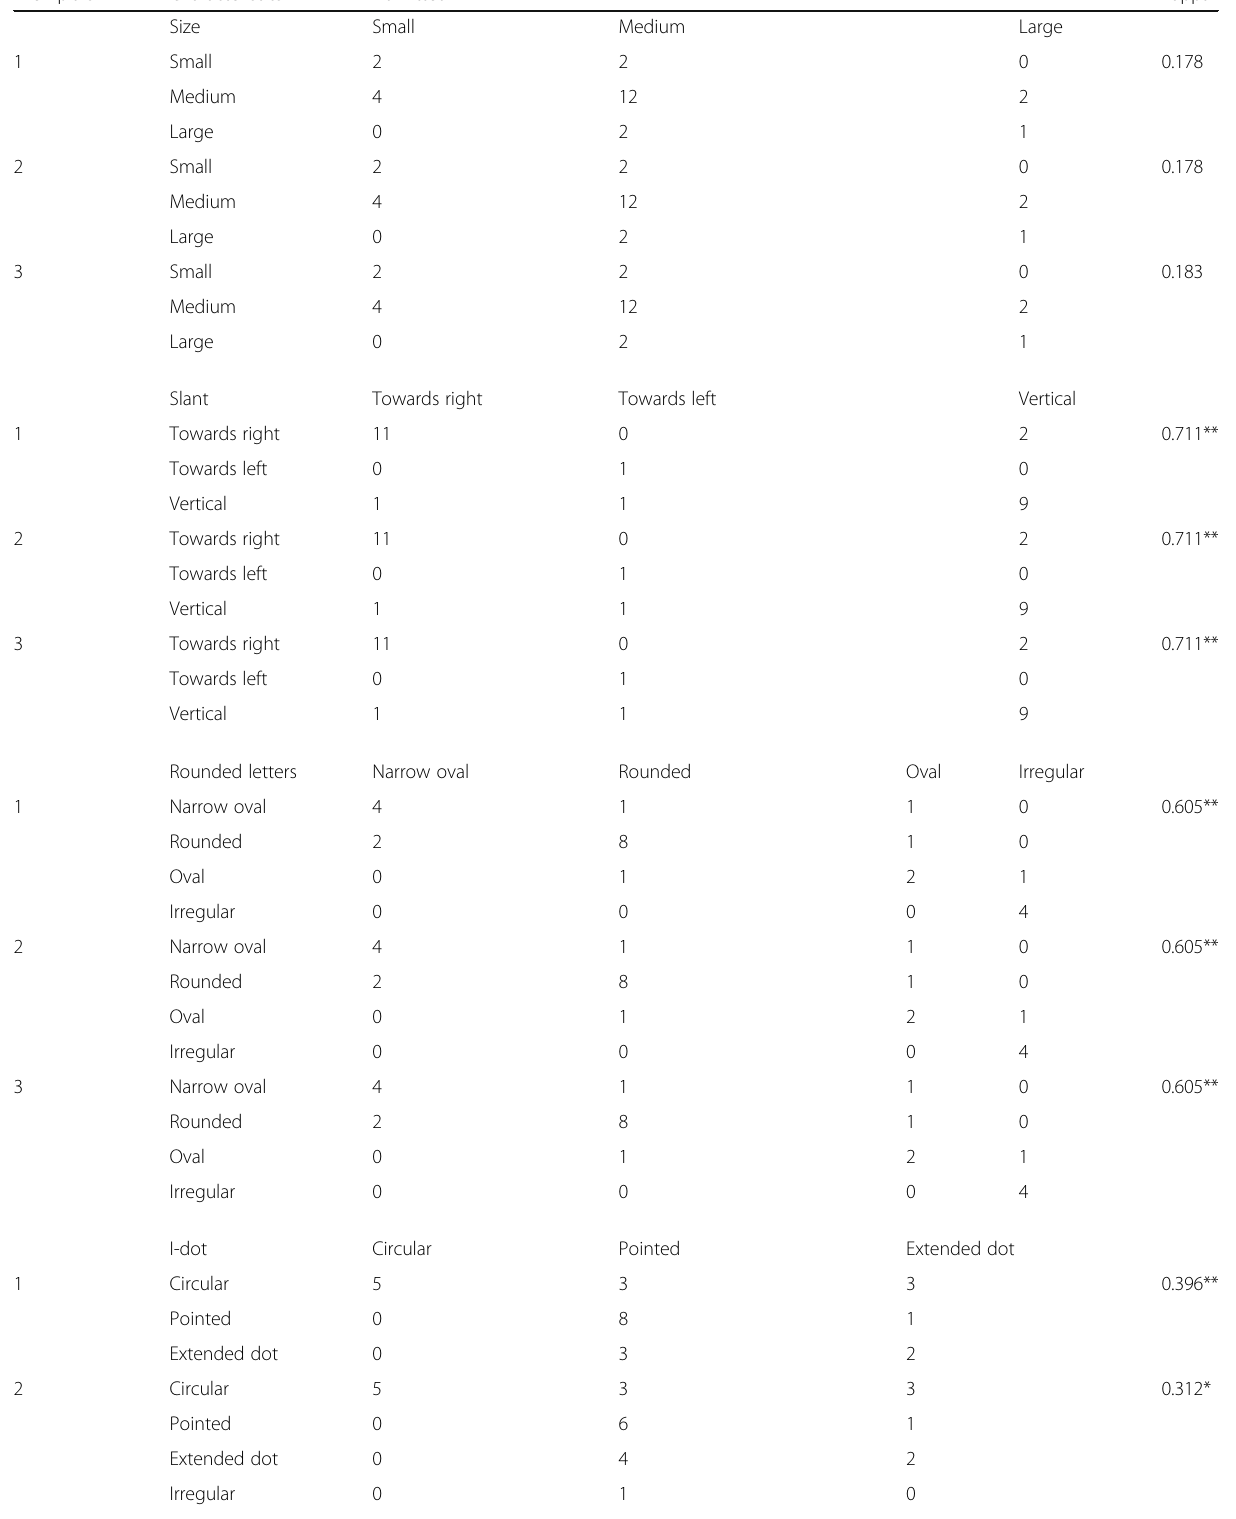
Table 3 Cohen ’ s kappa coefficient showing the agreement in characteristics between the admitted and the three exemplars